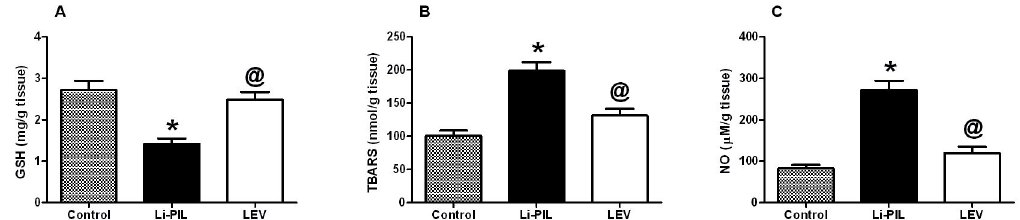
Figure 3. Effect of levetiracetam (LEV, 500 mg/kg i.p.) on hippocampal glutathione (GSH; A), thiobarbituric acid reactive substances (TBARS; B), and nitric oxide (NO; C) in lithium-pilocarpine (Li-PIL)-induced convulsion in rats. Values are means ± S.E.M. of 6 rats. As compared to control (*) and Li-PIL ( @ ) groups. Comparisons were carried out using one-way ANOVA followed by Student–Newman–Keuls Multiple Comparisons Test, P <0.05.